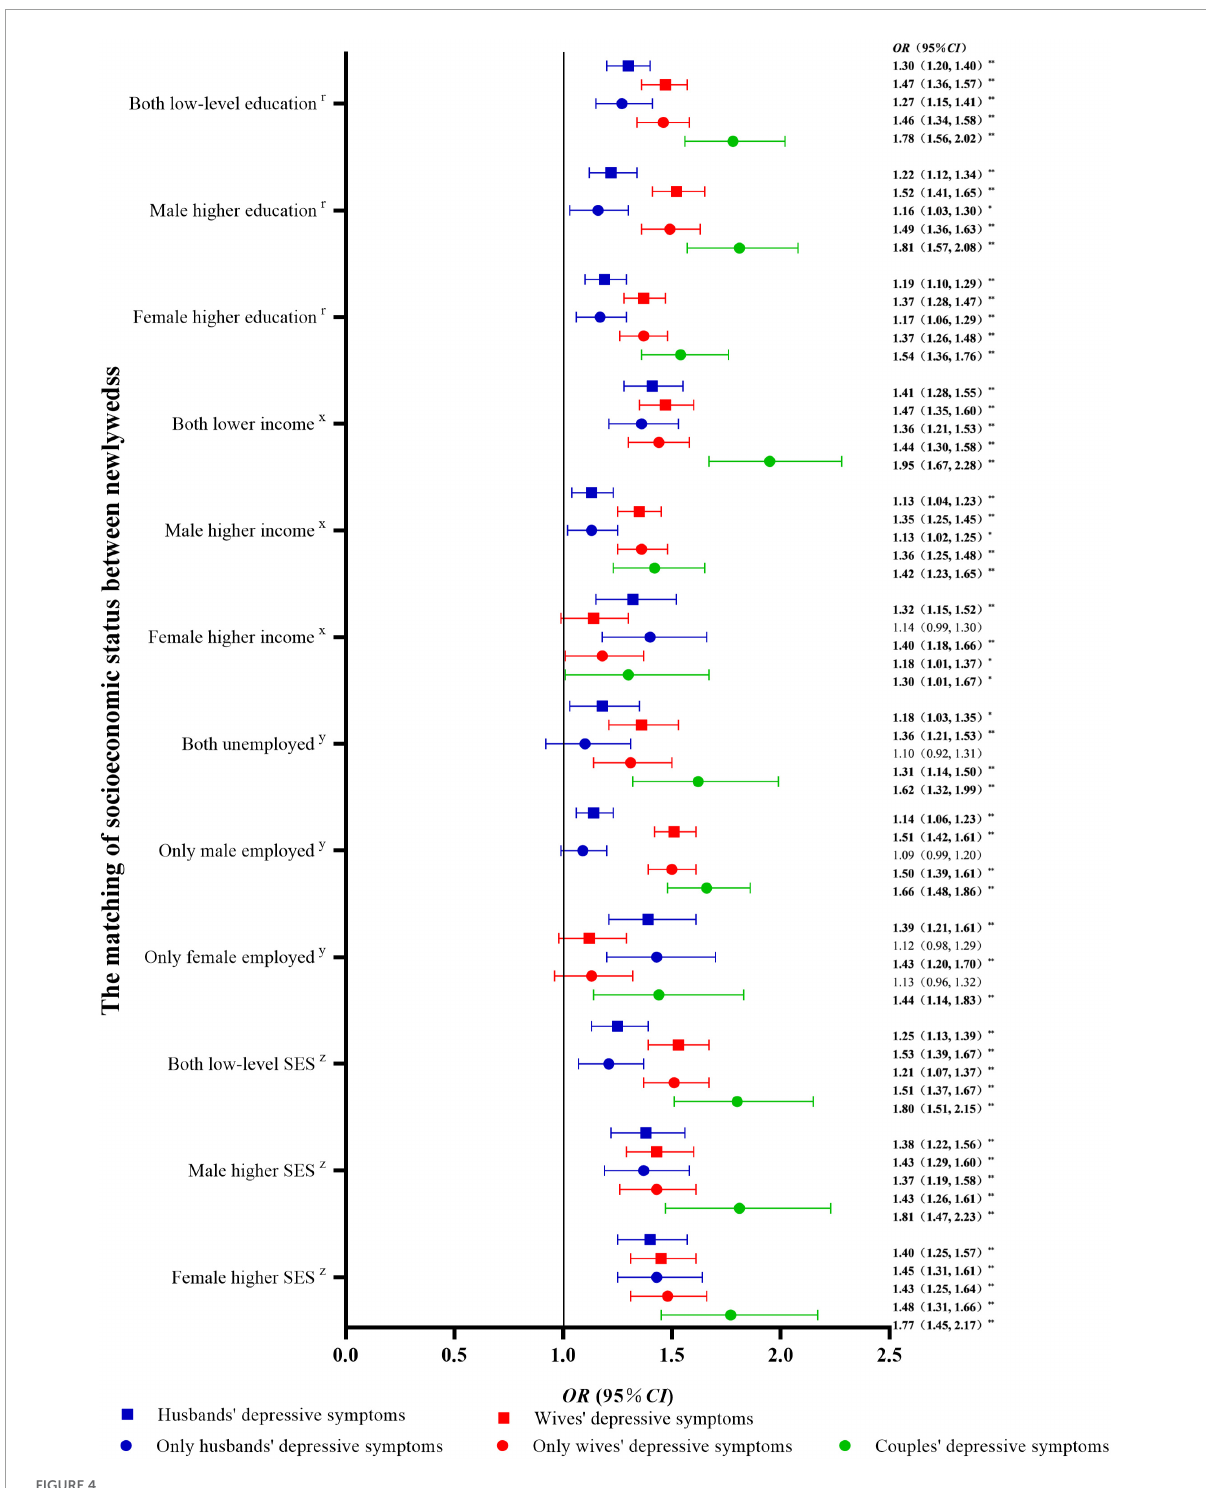
FIGURE4 Univariable logistic regression between socioeconomic status matching and depressive symptoms in newlyweds compared with non-depressive symptoms. OR, odds ratio; CI, confidence interval; SES, socioeconomic status. ∗∗ P < 0.01: ∗ P < 0.05. r Compared with newlyweds with both high-level education. x Compared with newlyweds with both high-level incomes. y Compared with newlyweds with both employed. z Compared with newlyweds with both high-level